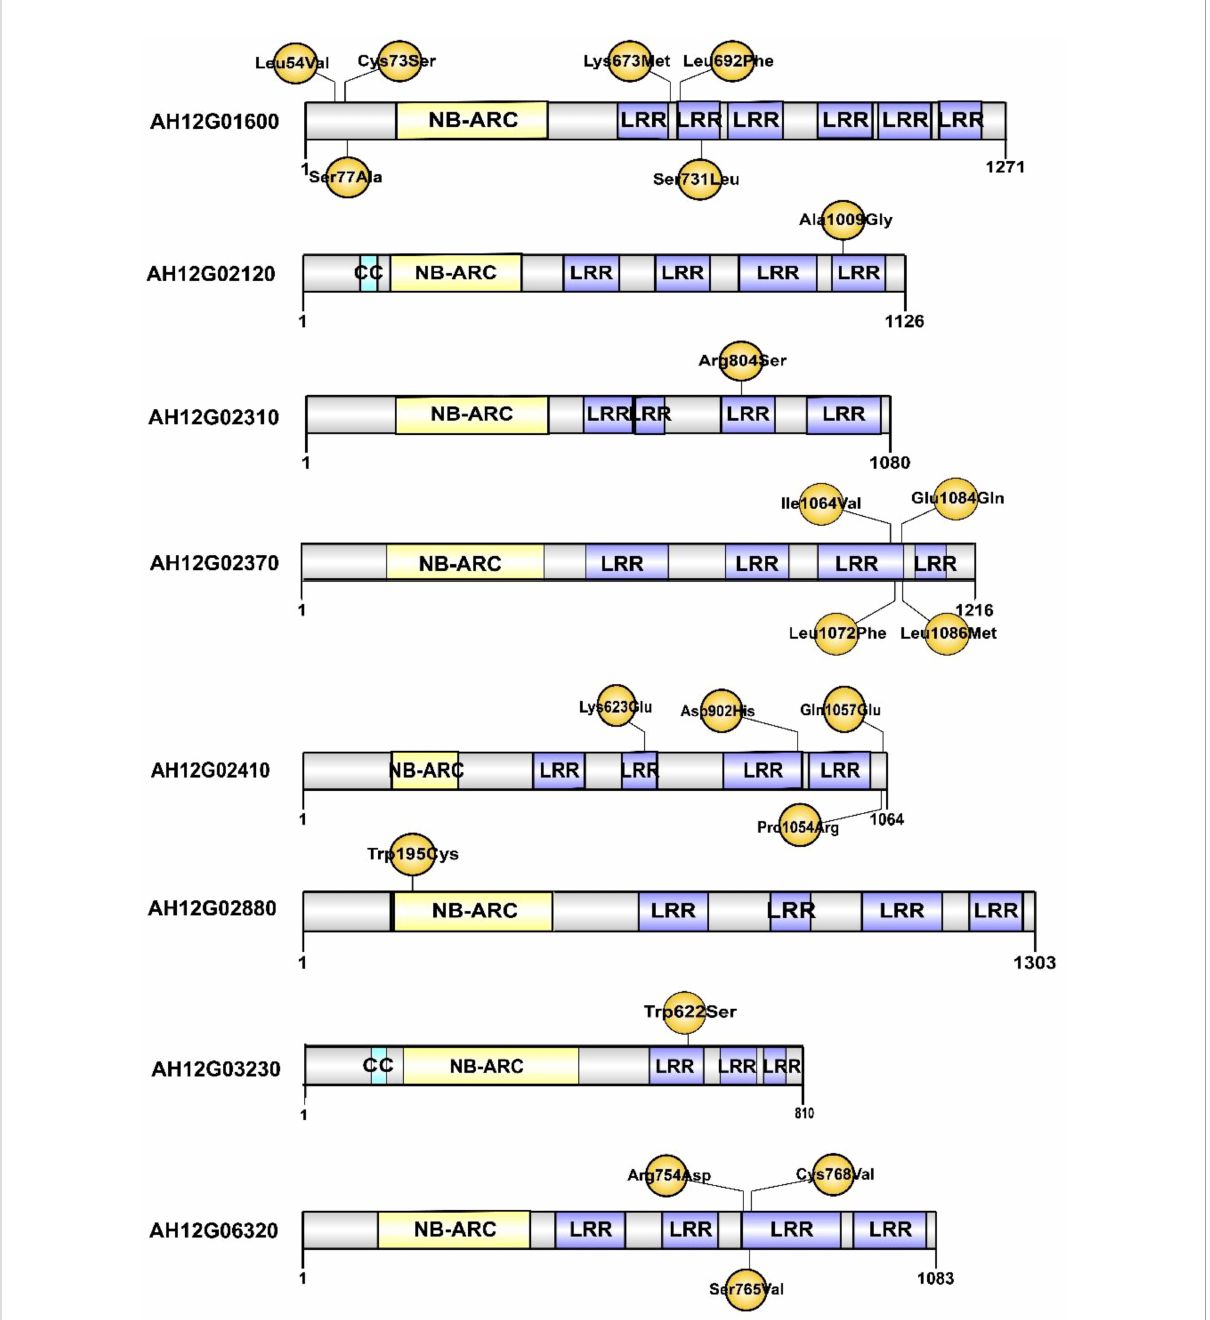
FIGURE 4 The putative resistance-related proteins associated with resistance to Ralstonia solanacearum infections. CC: Coil coiled. NB-ARC: Nucleotide- binding adapter shared by APAF-1 R proteins and CED-4. LRR: Leucine-rich repeat domain. The positions of amino acid changes caused by nonsynonymous SNPs are shown in